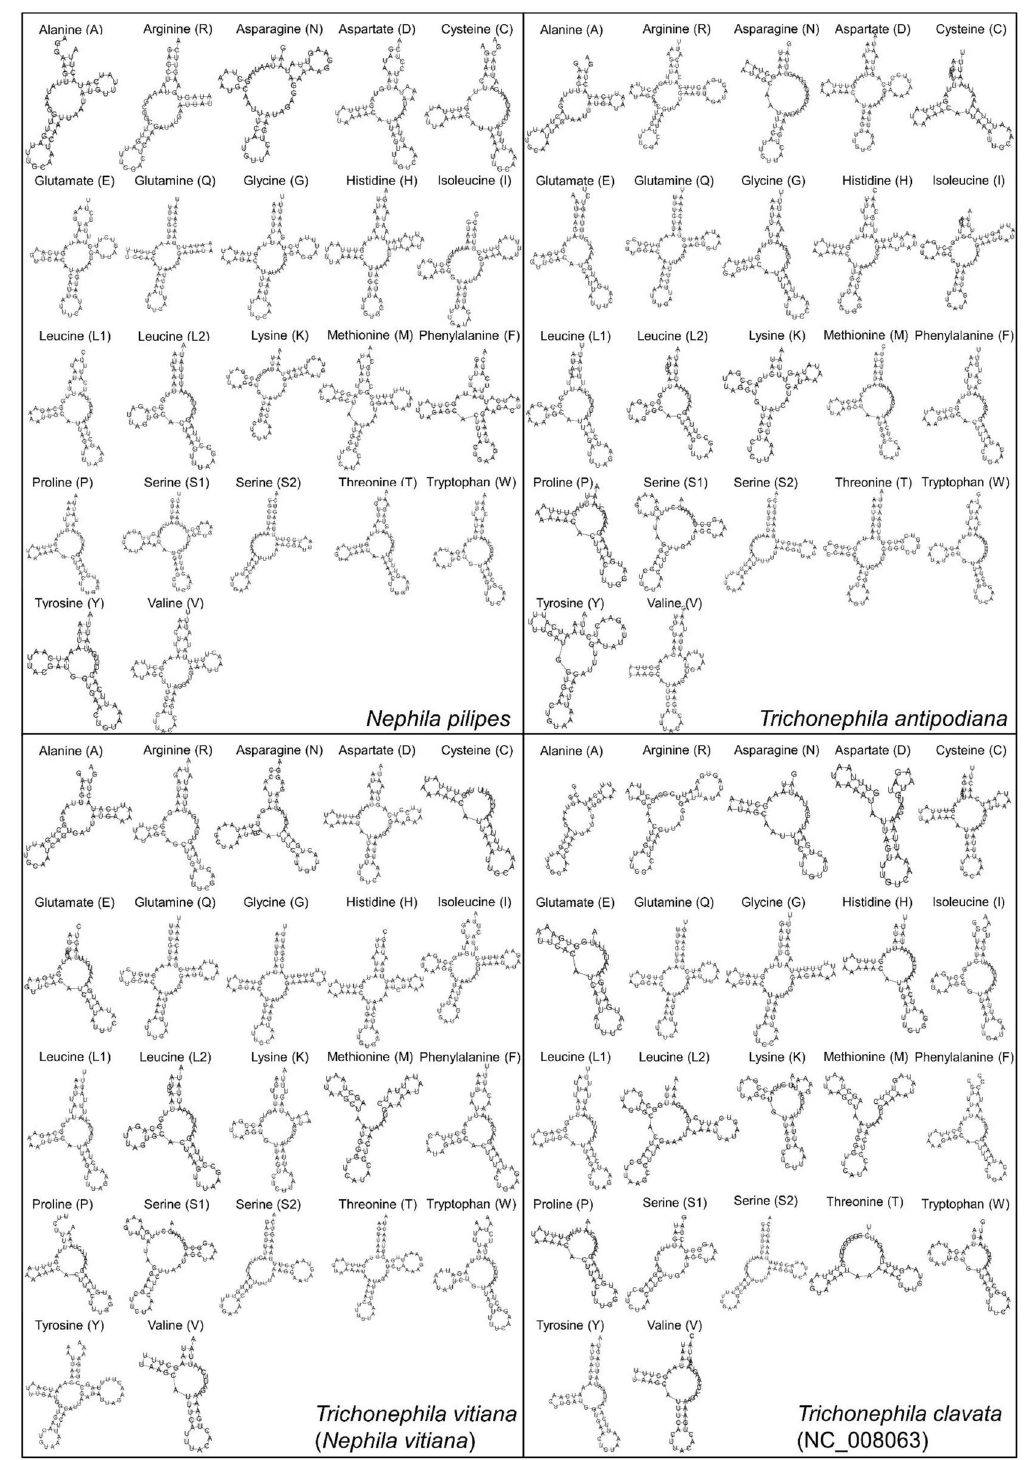
Figure 4. Cloverleaf structure of the 22 inferred tRNAs in the mitogenomes of Nephila and Trichonephila mitogenomes obtained from MITOS web-server (http:// mitos. bioinf. uni- leipz ig. de/ index.